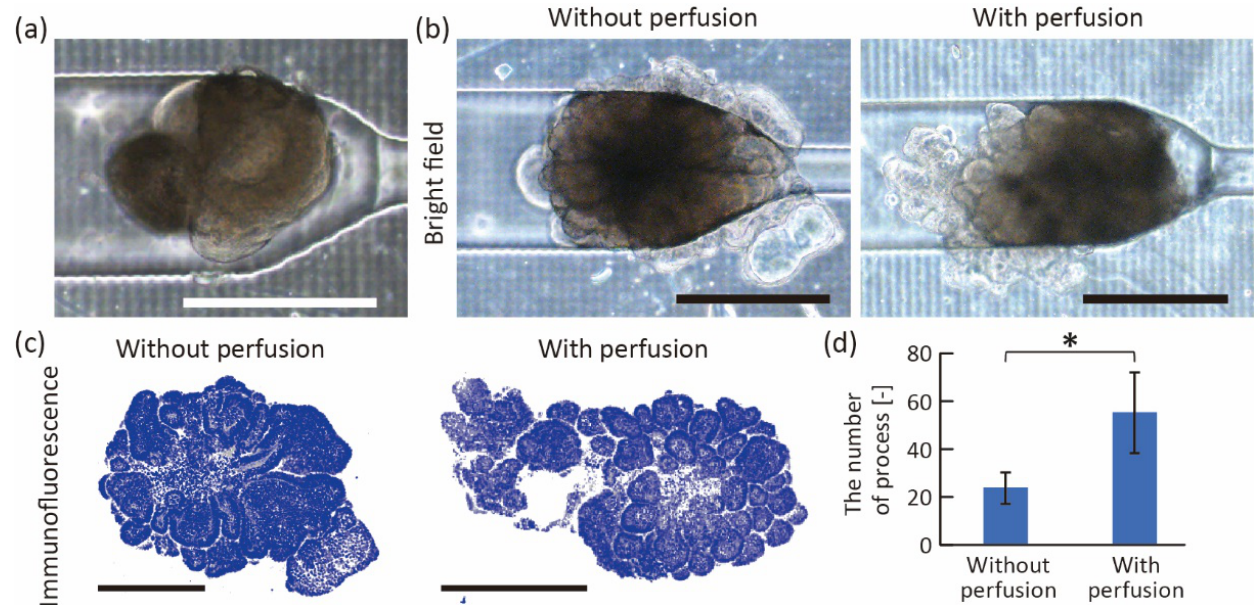
Figure 8. Budding formation of perfused organoids, showing localization of lysozyme (paneth cell marker) in the intestinal organoid with and without perfusion culture. Green shows lysozyme and white shows actin. Scale bars are 200 µm (overall image) and 100 µm (magnified image). 4. Conclusions We propose a simple microfluidic device to trap, fuse, and stimulate human epithe- lial cell-derived intestinal organoids. The organoids were trapped and aligned in the de- vice under hydrostatic pressure without any obvious deformation. We demonstrated that the trapped organoids were fused in the device within two days and formed large tube- like organoids. Furthermore, applying flow to the basal side of the organoid increased the number of buddings. Thus, we believe that our device will be a useful tool for various investigations of intestinal organoids, such as studying the effects of chemical and flow